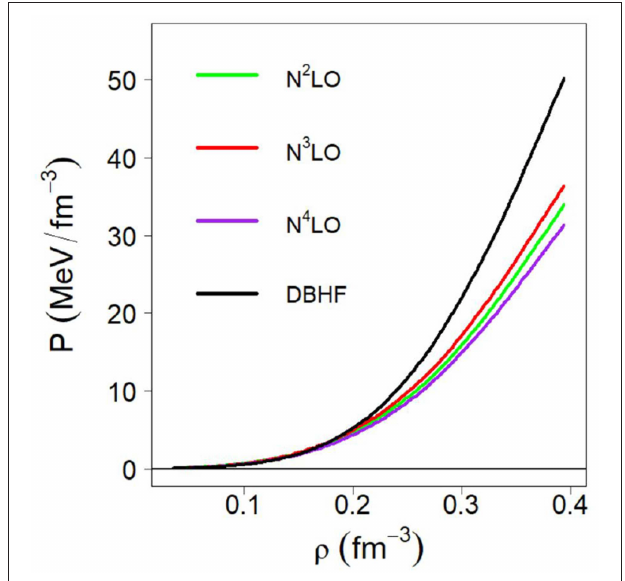
FIGURE 15 | Pressure in β -stable matter from the red curve on the LHS of Figure 14 compared with the predictions from the LHS of Figure 11 .